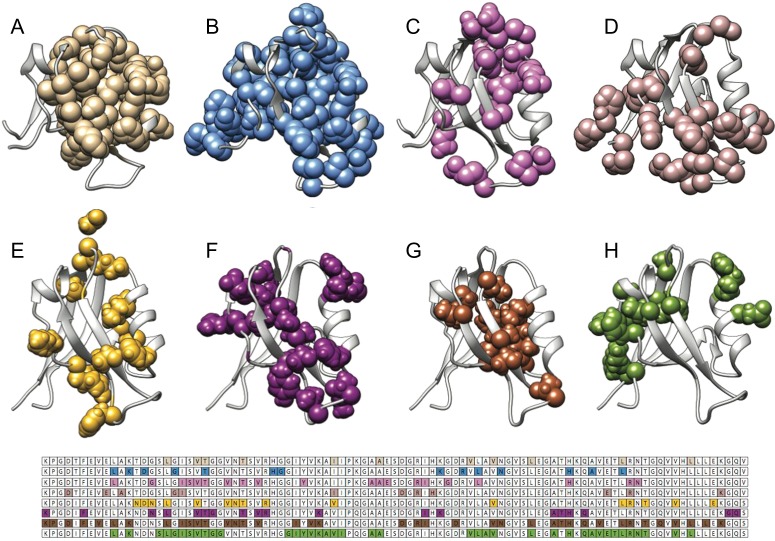
Allosteric networks in PTP-BL PDZ2 determined by different approaches. Allosteric networks mapped in mouse and human PTP-BL PDZ2 (pdb 1GM1 and pdb 3LNX) with different methods: (A) Thermodynamic double mutant cycle (Gianni et al., 2011) (B) NMR, relaxation (Fuentes et al., 2006) (C) NMR, relaxation, in combination with Molecular dynamics simulations (Dhulesia et al., 2008) (D) NMR (15N HSQC spectra upon titration) (van den Berk et al., 2007) (E) Rigid-residue scan (RRS) (Kalescky et al., 2016) (F) Machine learning models (Kalescky et al., 2016) (G) Protein structure network and elastic network model (PSN-ENM) (Raimondi et al., 2013) (H) Perturbation response scanning (PRS) (Gerek and Ozkan, 2011).